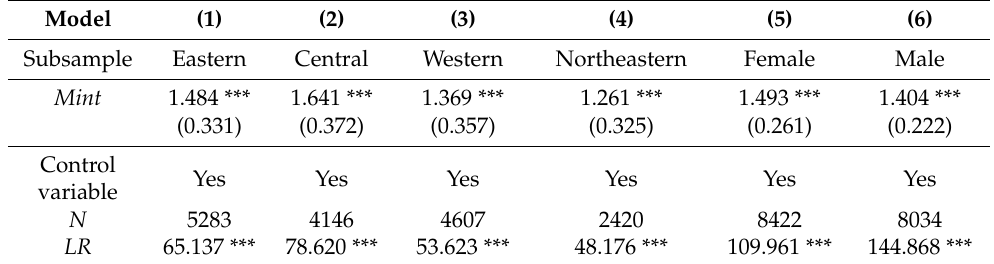
Table 4. Estimated results for the effect of Internet use on divorce risk by region and